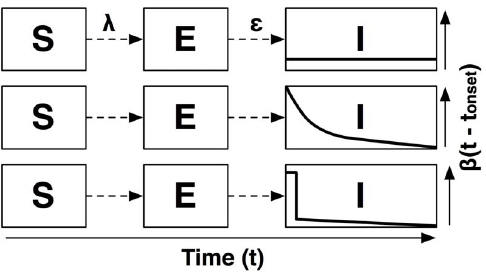
Figure 2. Illustration of model structure for Models 1, 2 & 3. The figure illustrates the change in infectiousness over time, for Model 1 (SEIR; top), Model 2 (Exponential decay; middle) and Model 3 (Burst; bottom). l is the force of infection, i.e. the rate at which susceptible individuals are recruited to the latent class, E , and e is the mean rate at which infected individuals progress to infectiousness. The asymptom- atic class, A , and recovered class, R , are omitted from the figure for visual